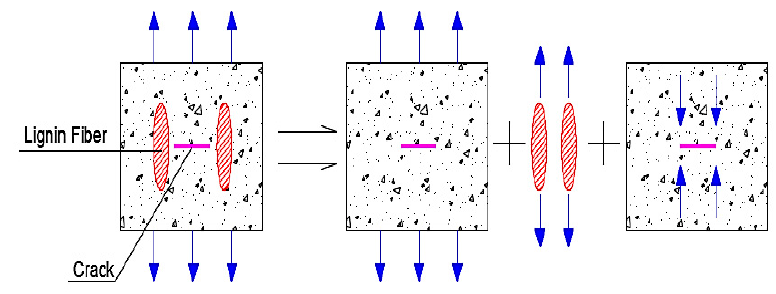
Figure 7. Crack and lignin fiber.